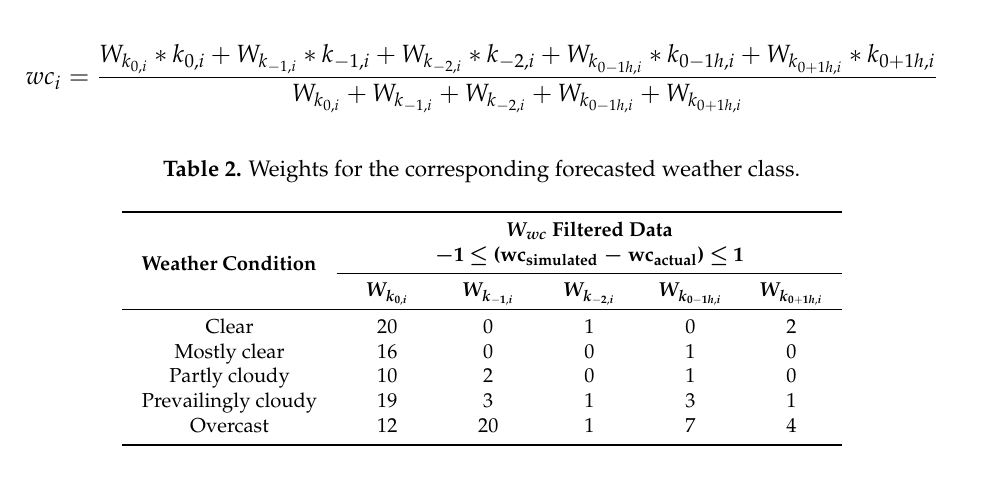
Table 2. Weights for the corresponding forecasted weather class.